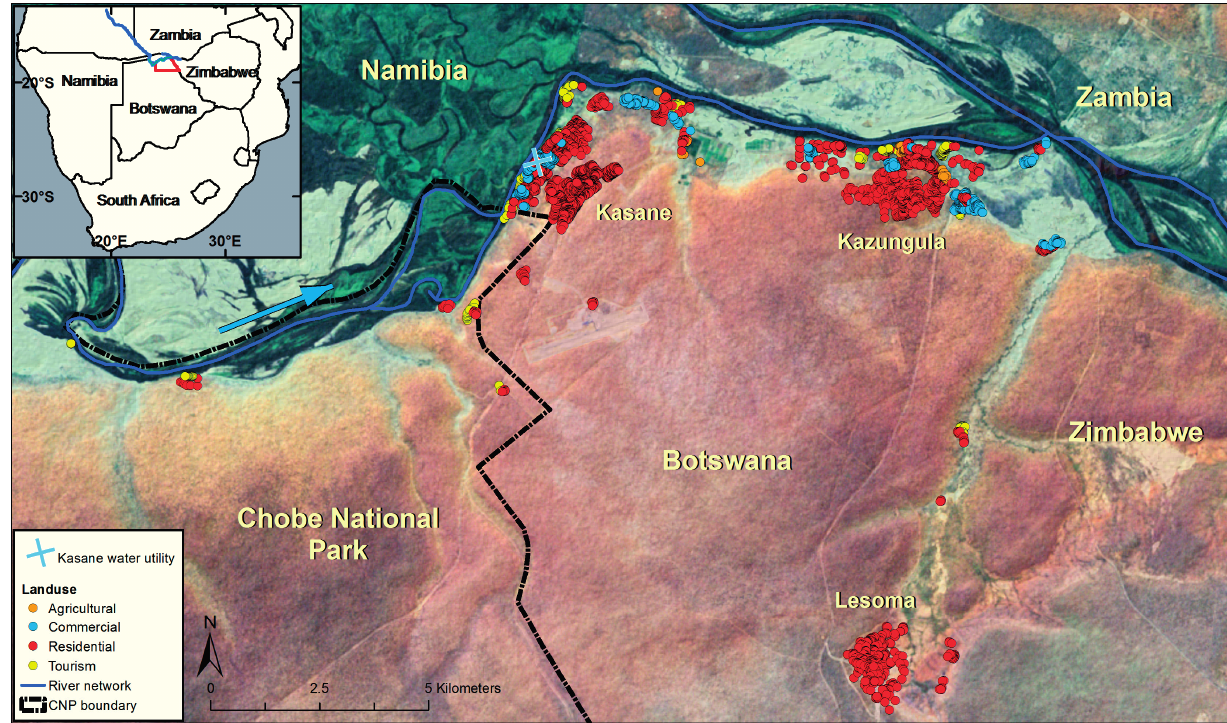
Figure 1. The study was conducted in Northern Botswana in nonsewered residential areas in the towns of Kasane, Kazungula, and Lesoma. Botswana is located in Southern Africa (inset). Buildings are noted by land use type (agricultural, commercial, residential and tourism associated). Residential dwellings are noted in red. Kasane and Kazungula are located near the Chobe River (blue line between Namibia and